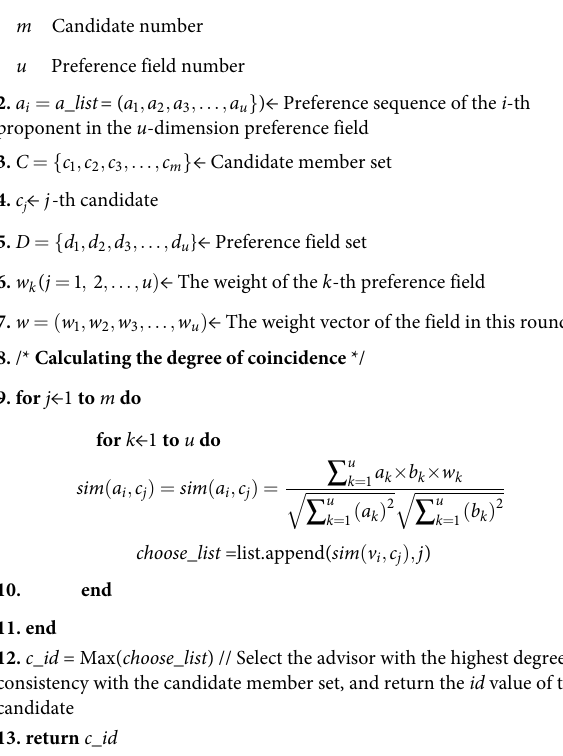
Algorithm 5 Executor